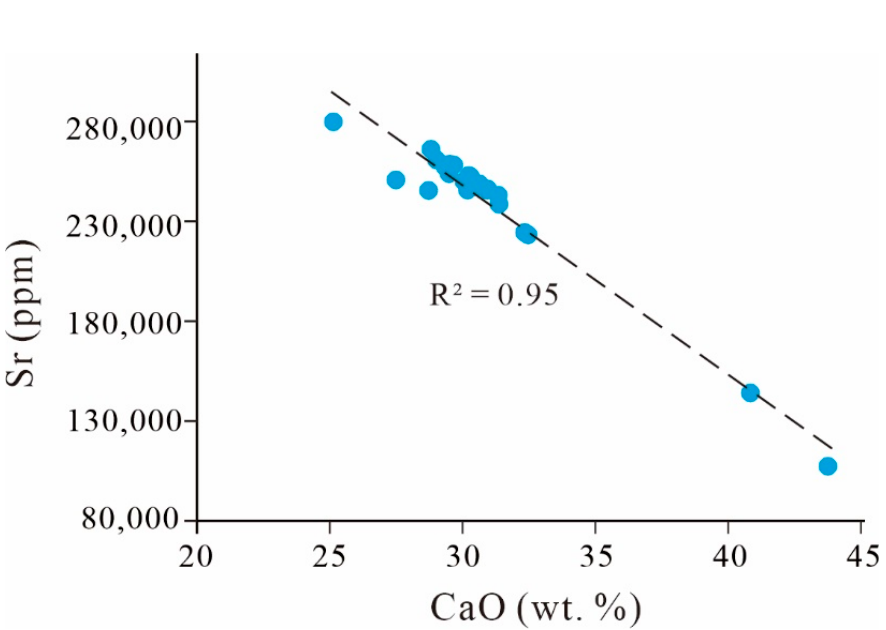
Figure 13. Correlation coefficients of Sr and Cao in samples from the celestine deposits in Xishan